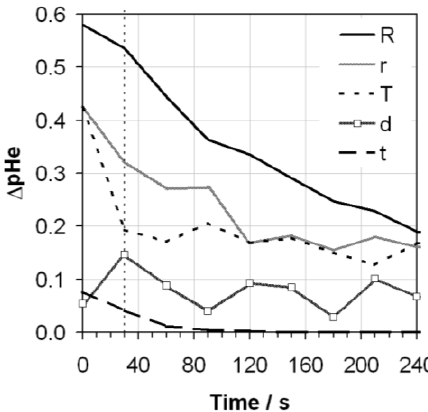
Figure 5. Absolute variability in pHe (  pHe) as a function of time cause by variability observed in the key parameters of: reproducibility (R, on the legend); repeatability (r); solution temperature (T); vortex depth (d); and measurement time (t), when using the ASTM D6423 method to measure ethanol containing 0.02 g/g of water. The ASTM D6423 specified measurement time is also indicated (vertical dotted